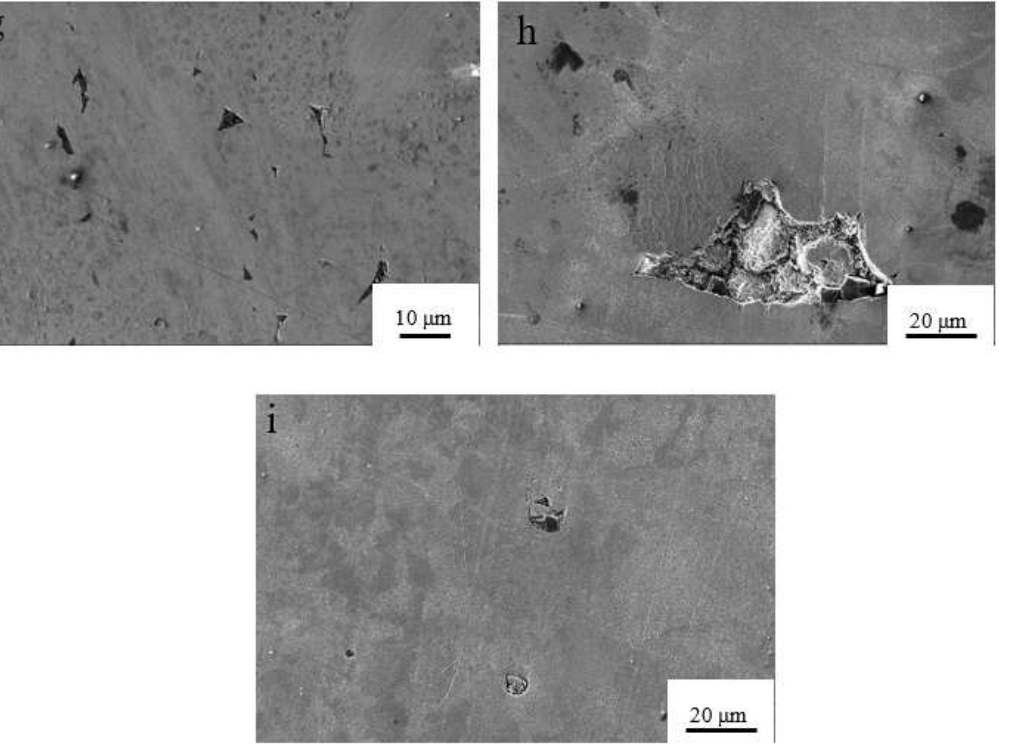
Figure 11. Forming quality at different energy densities: ( a ) E = 83.3 J/mm 3 , ( b ) E = 41.7 J/mm 3 , ( c ) E = 44.6 J/mm 3 , ( d ) E = 65.0 J/mm 3 , ( e ) E = 67.7 J/mm 3 , ( f ) E = 77.4 J/mm 3 , ( g ) E = 100.0 J/mm 3 , ( h ) E = 111.1 J/mm 3 , and ( i ) E = 57.1 J/mm 3.